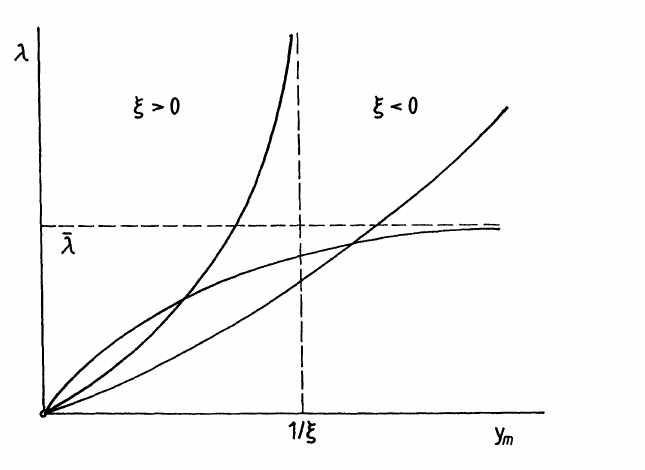
FIGURE 9(b) The bifurcation diagram for functions w(y) which are entirely concave in the generalized